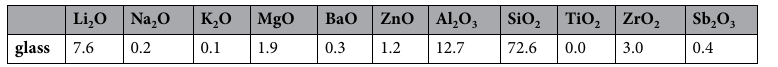
Table 1. Chemical composition of the studied glass in